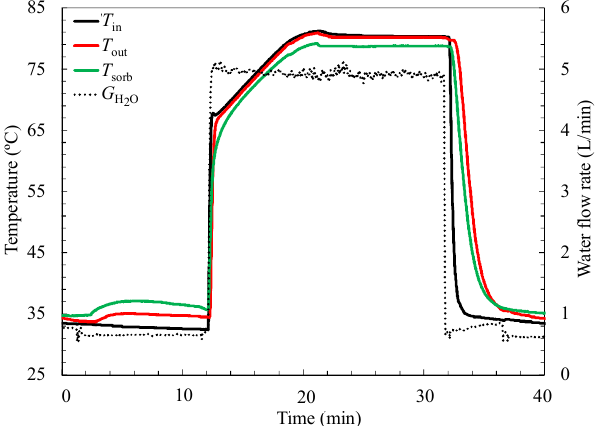
Figure 6. Temperature of the composite material; the inlet and outlet temperatures of the heat exchanger on the reactor side changes with time.